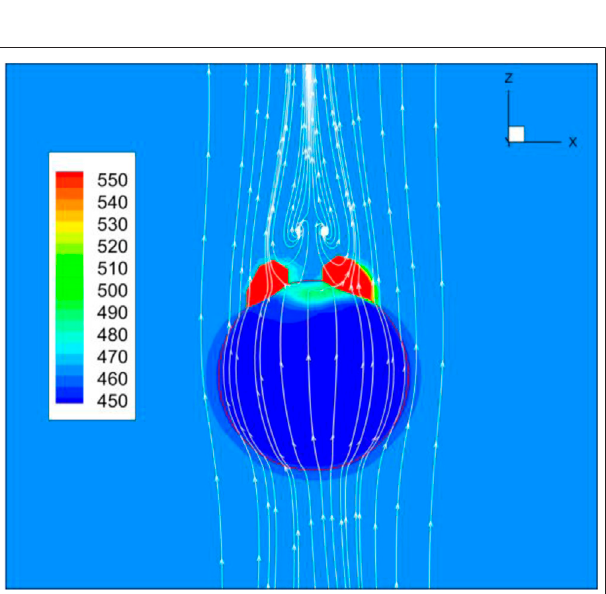
FIGURE 7 | Mass fl ow rate distribution in the cross section of round blister channel.